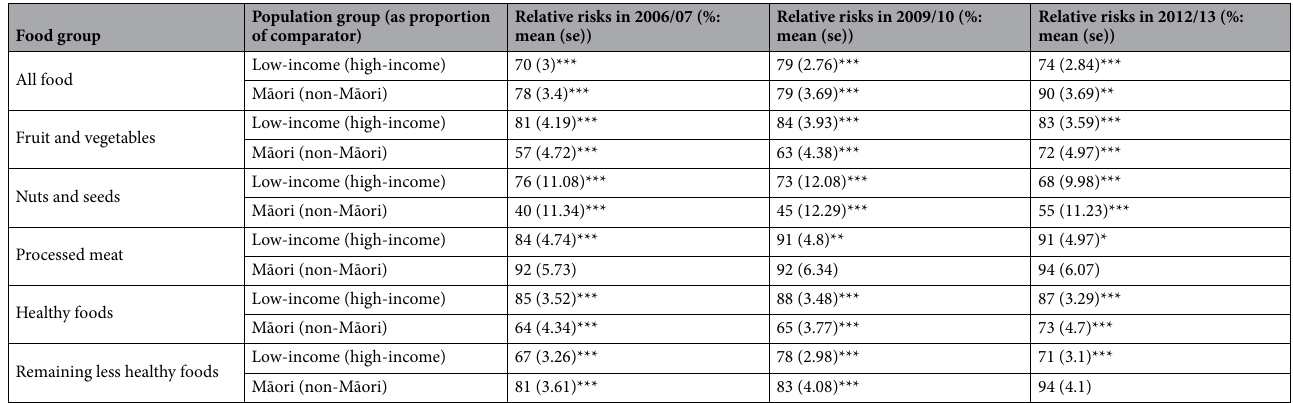
Table 3. Relative risks a (%) in household food purchase expenditure for low-income as proportion of high- income, and Māori as proportion of non-Māori households, Household Economic Surveys 2006/07, 2009/10, and 2012/13. a Values in this table were derived using linear regressions with the survey year and income- level/ethnicity as independent variables. *,**,***Denote statistical significance at the 10%, 5% and 1% levels,